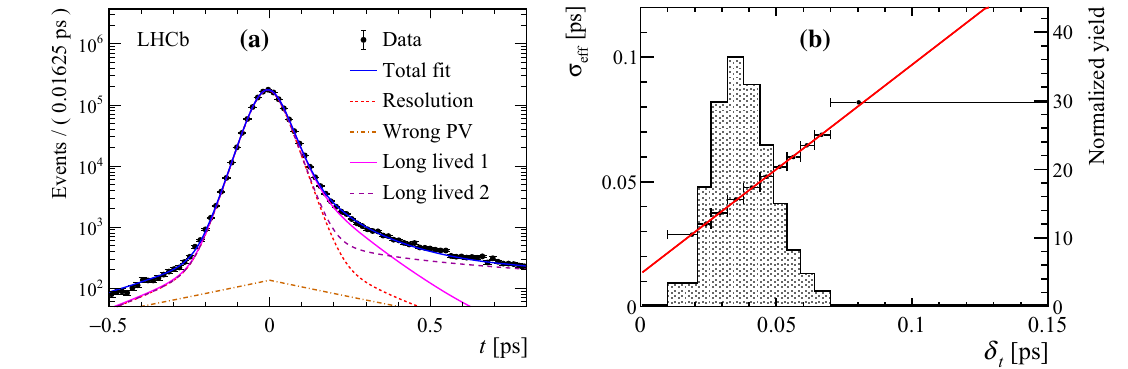
Fig. 3 a Decay-timedistributionoftheprompt J /ψ K + K − calibration sample with the result of an unbinned maximum-likelihood fit overlaid in blue. The overall triple-Gaussian resolution is represented by the dashed red line, while the two long-lived and the wrong-PV compo- nents are shown by the long-dashed-dotted and dashed-multiple-dotted brown and pink lines and the long-dashed purple line, respectively. b Variation of the effective single-Gaussian decay-time resolution, σ eff ,